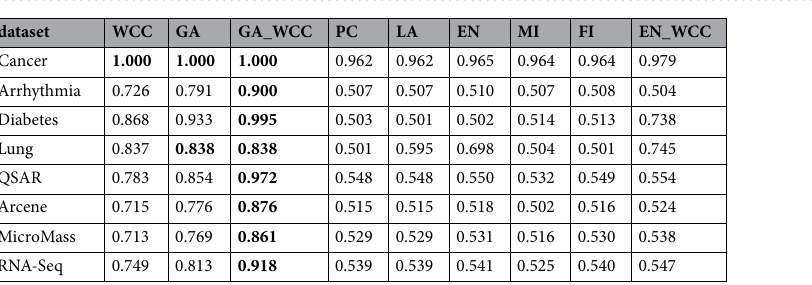
Table 4. The AUC values of the methods in the first category of the results. The best outcomes have been highlighted. WCC, world competitive contests algorithm; GA, genetic algorithm; PC, Pearson correlation; LA, Laplacian score; EN, entropy; MI, mutual information; FI, Fisher score.